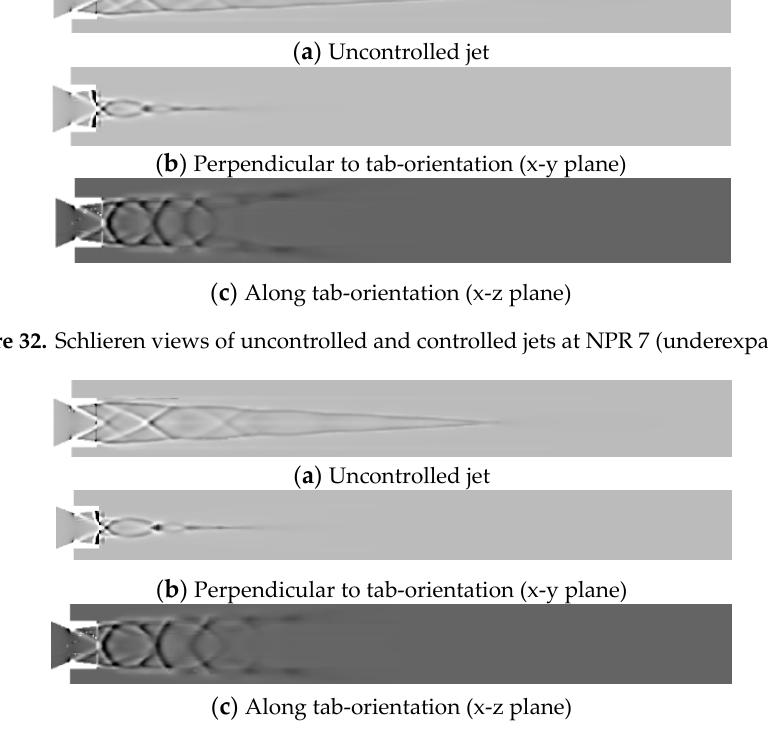
Figure 33. Schlieren views of uncontrolled and controlled jets at NPR 8 (underexpansion).